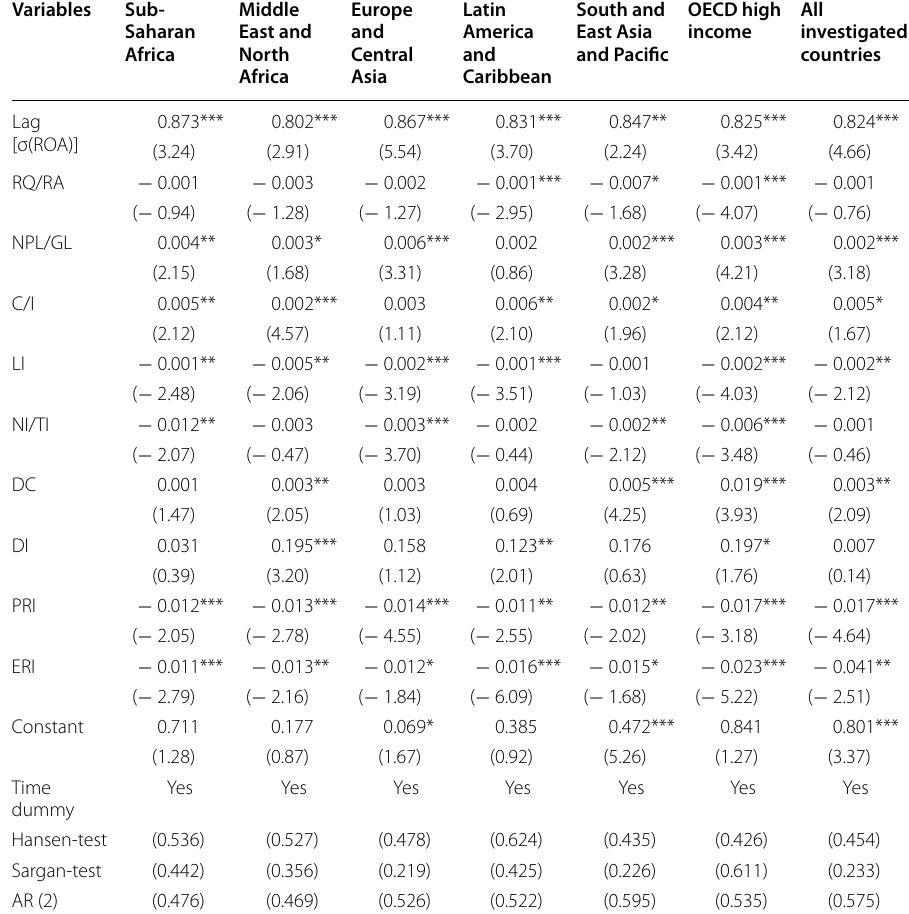
Table 4 Effect of political and economic risks on banking sector risk-taking in the different regions